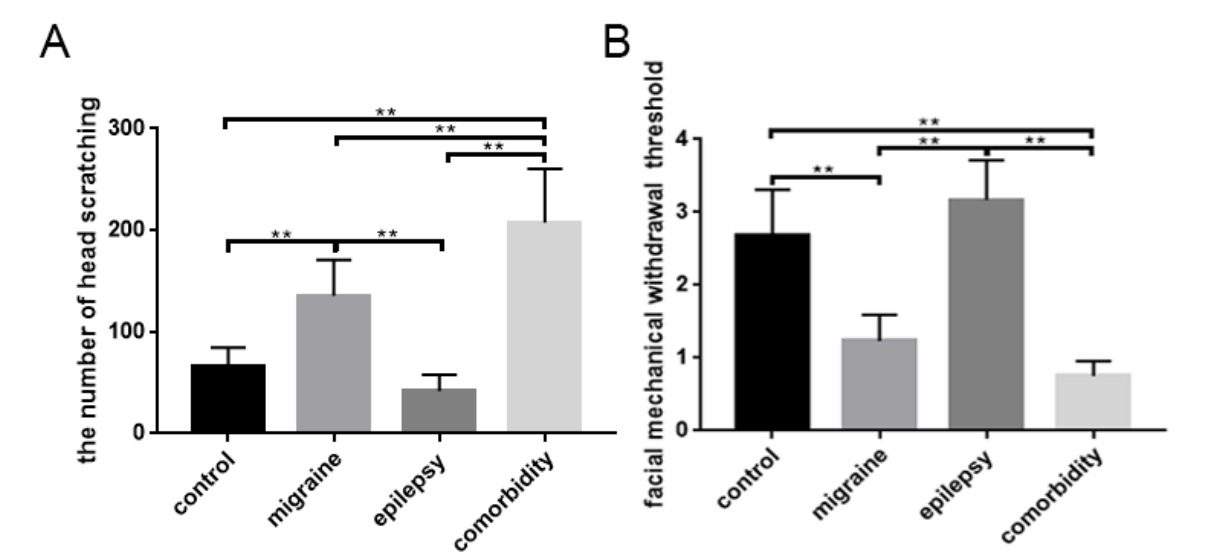
Figure 1. Inflammatory soup makes migraine symptoms worse. Significant differences in the amount of head scratching ( A ) and facial mechanical withdrawal threshold ( B ) were observed among four groups ( n = 6; ** p < 0.01). groups ( n = 6; ** p < 0.01). Table 3. Comparison of the amount of head scratching and facial mechanical withdrawal threshold in different groups of